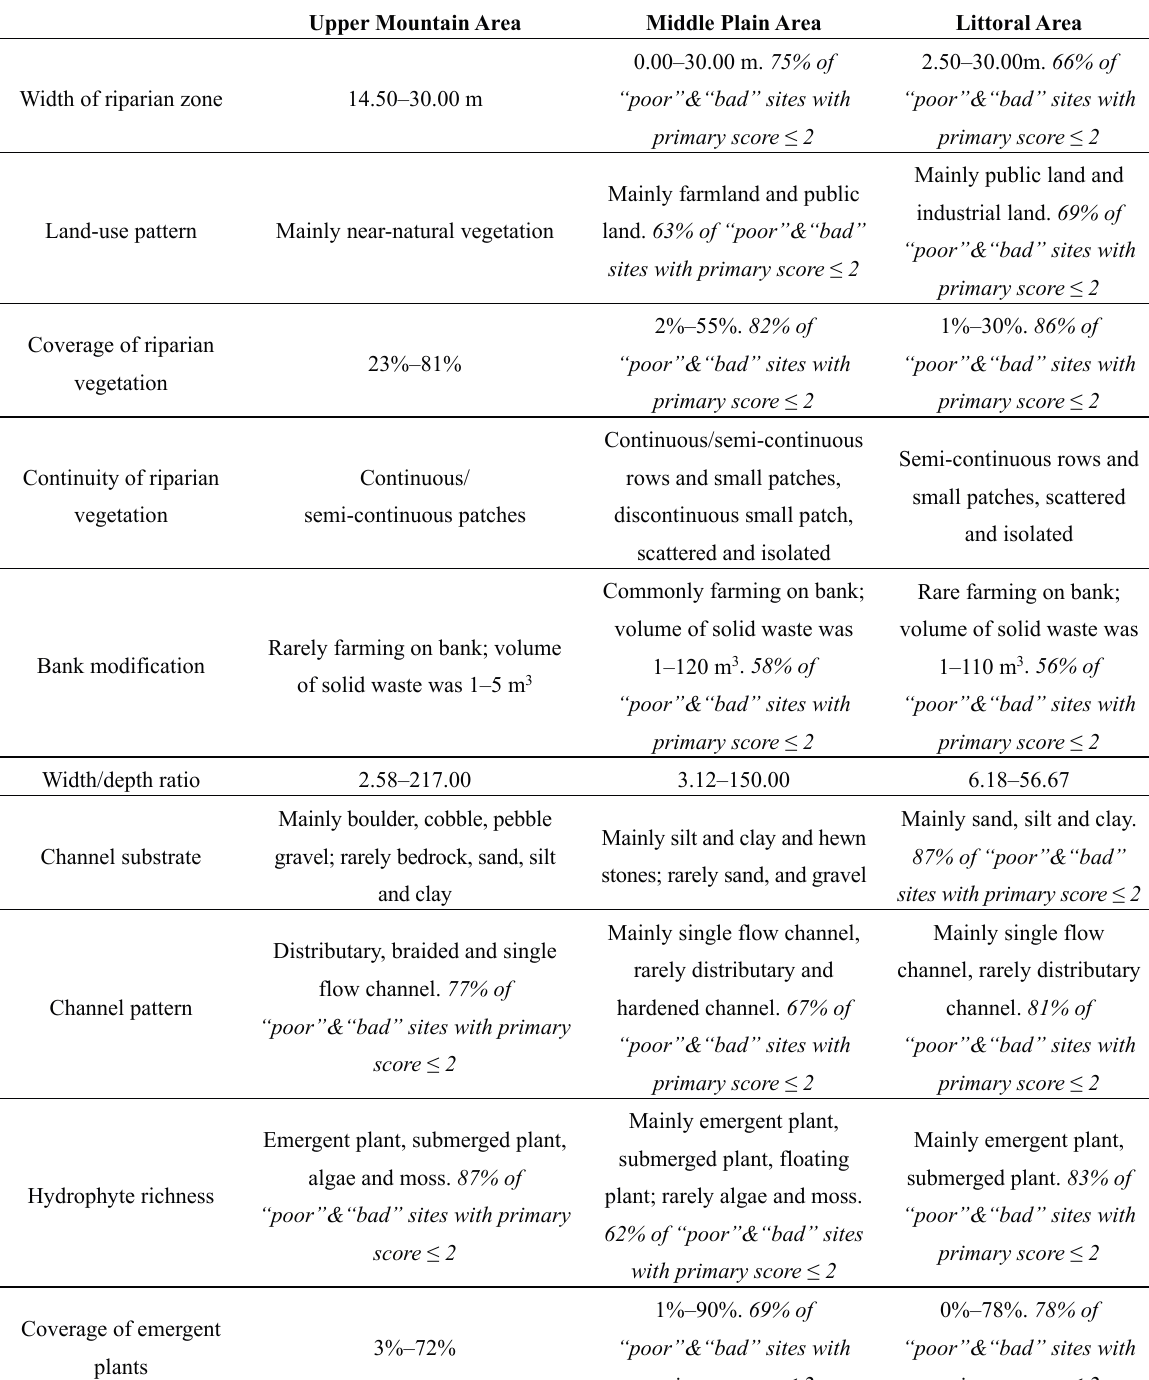
Table 3. Indicators of river habitat condition in the